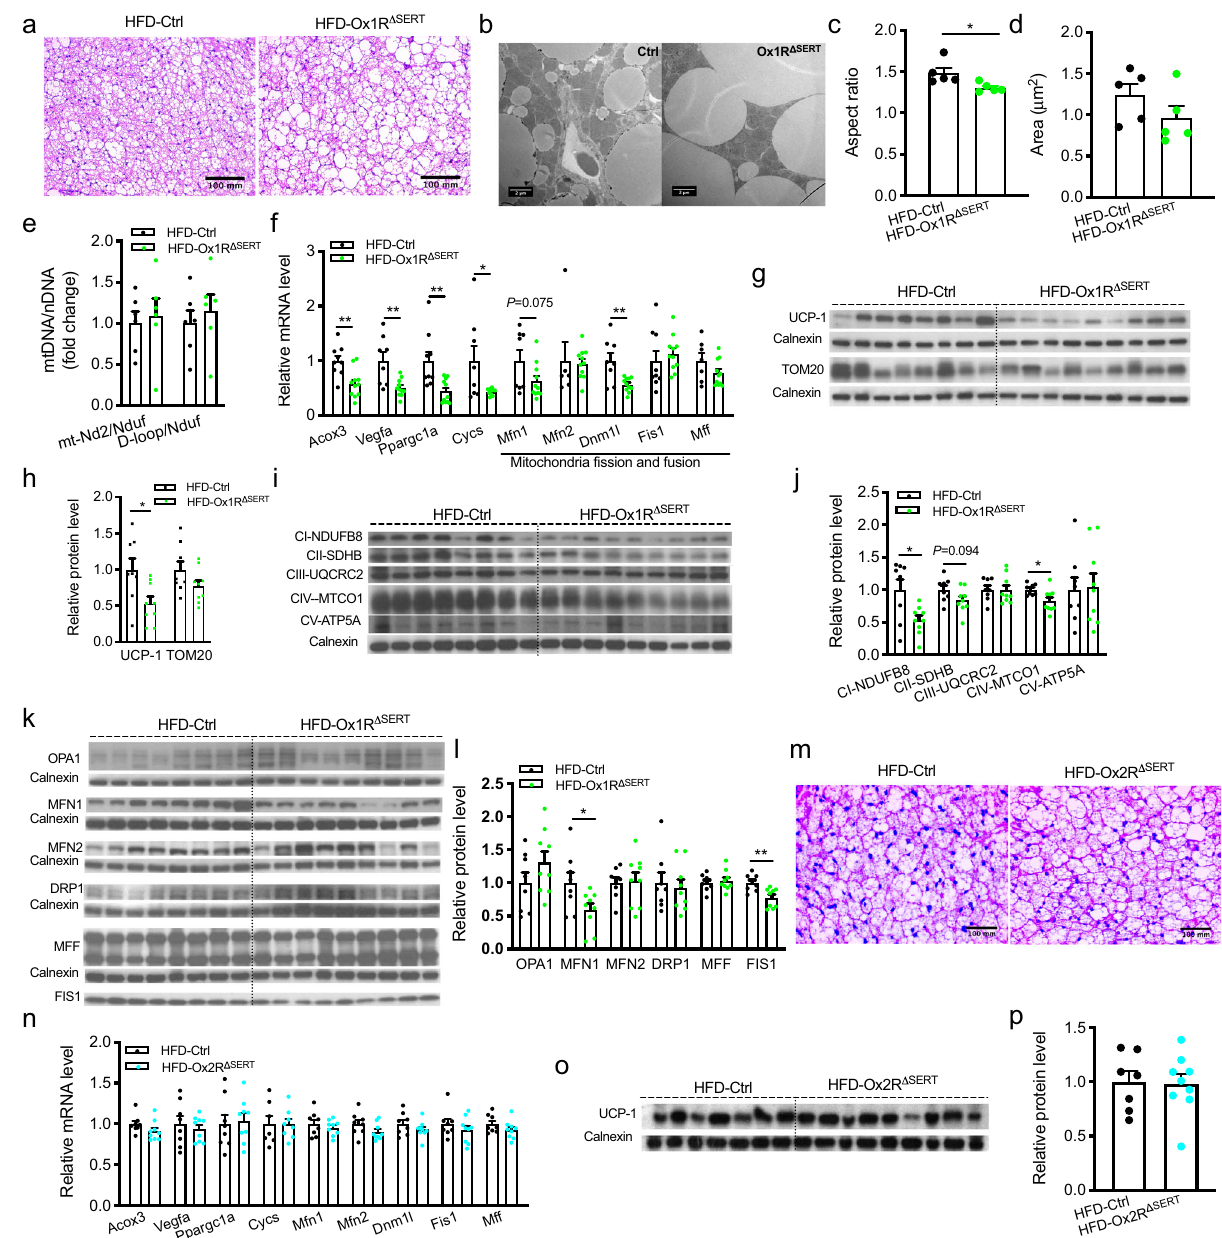
Fig. 7 Increased fat and impaired mitochondrial function in brown adipose tissue (BAT) of Ox1R Δ SERT mice while BAT morphology and mitochondrial function are unaltered in Ox2R Δ SERT mice fed a high-fat diet (HFD). a H&E staining of BAT of control or Ox1R Δ SERT mice. HFD-Ctrl, n = 8; HFD- Ox1R Δ SERT , n = 10. b Representative electronic microscope (EM) images of BAT of control and Ox1R Δ SERT mice, and quanti fi cation of c mitochondrial area and d mitochondrial aspect ratio. n = 5. p = 0.033. e Relative mitochondrial DNA content of control and Ox1R Δ SERT mice. n = 6. f Gene expression levels in BAT of control and Ox1R Δ SERT mice. Control: n = 6 ( Mfn2 ), 7 ( Mff) , 8 ( Vegfa , Cycs , Mfn1 , Dnm1l ) and 9 ( Acox3 , Ppargc1a , Fis1); Ox1R Δ SERT , n = 11. p = 0.0026 ( Acox3 ), 0.0031 ( Vegfa ), 0.0038 ( Ppargc1a ), 0.024 ( Cycs ), 0.075 ( Mfn1 ) and 0.0035 ( Dnm1l ). g , h Western blot images and quanti fi cation of UCP-1 and TOM20 protein, i , j OXPHOS protein, and k , l mitochondrial fusion and fi ssion protein in BAT of control and Ox1R Δ SERT mice. UCP1 and FIS1 were from the same western blot gel and thus shared the loading control. HFD-Ctrl, n = 8; HFD-Ox1R Δ SERT , n = 9. p = 0.020 (UCP − 1), 0.015 (CI- NDUFB8), 0.094 (CII-SDHB), 0.021 (CIV-MTCO1), 0.038 (MFN1) and 0.0039 (FIS1). m H&E staining of BAT of control and Ox2R Δ SERT mice. HFD-Ctrl, n = 11; HFD-Ox2R Δ SERT , n = 9. n Gene expression levels in BAT of control and Ox2R Δ SERT mice. HFD-Ctrl, n = 8 except for Cycs ( n = 7); HFD-Ox2R Δ SERT , n = 9 except for Cycs ( n = 8). o , p Western blot images and quanti fi cation of UCP-1 protein in BAT of control and Ox2R Δ SERT mice. HFD-Ctrl, n = 7; HFD- Ox2R Δ SERT , n = 9. Scale bar: 100 mm in ( a , m ) and 2 µ m ( b ). Data are represented as means ± SEM. * p < 0.05, ** p < 0.01; as determined by unpaired two- tailed Student ’ s t -test. Source data are provided as a Source Data fi